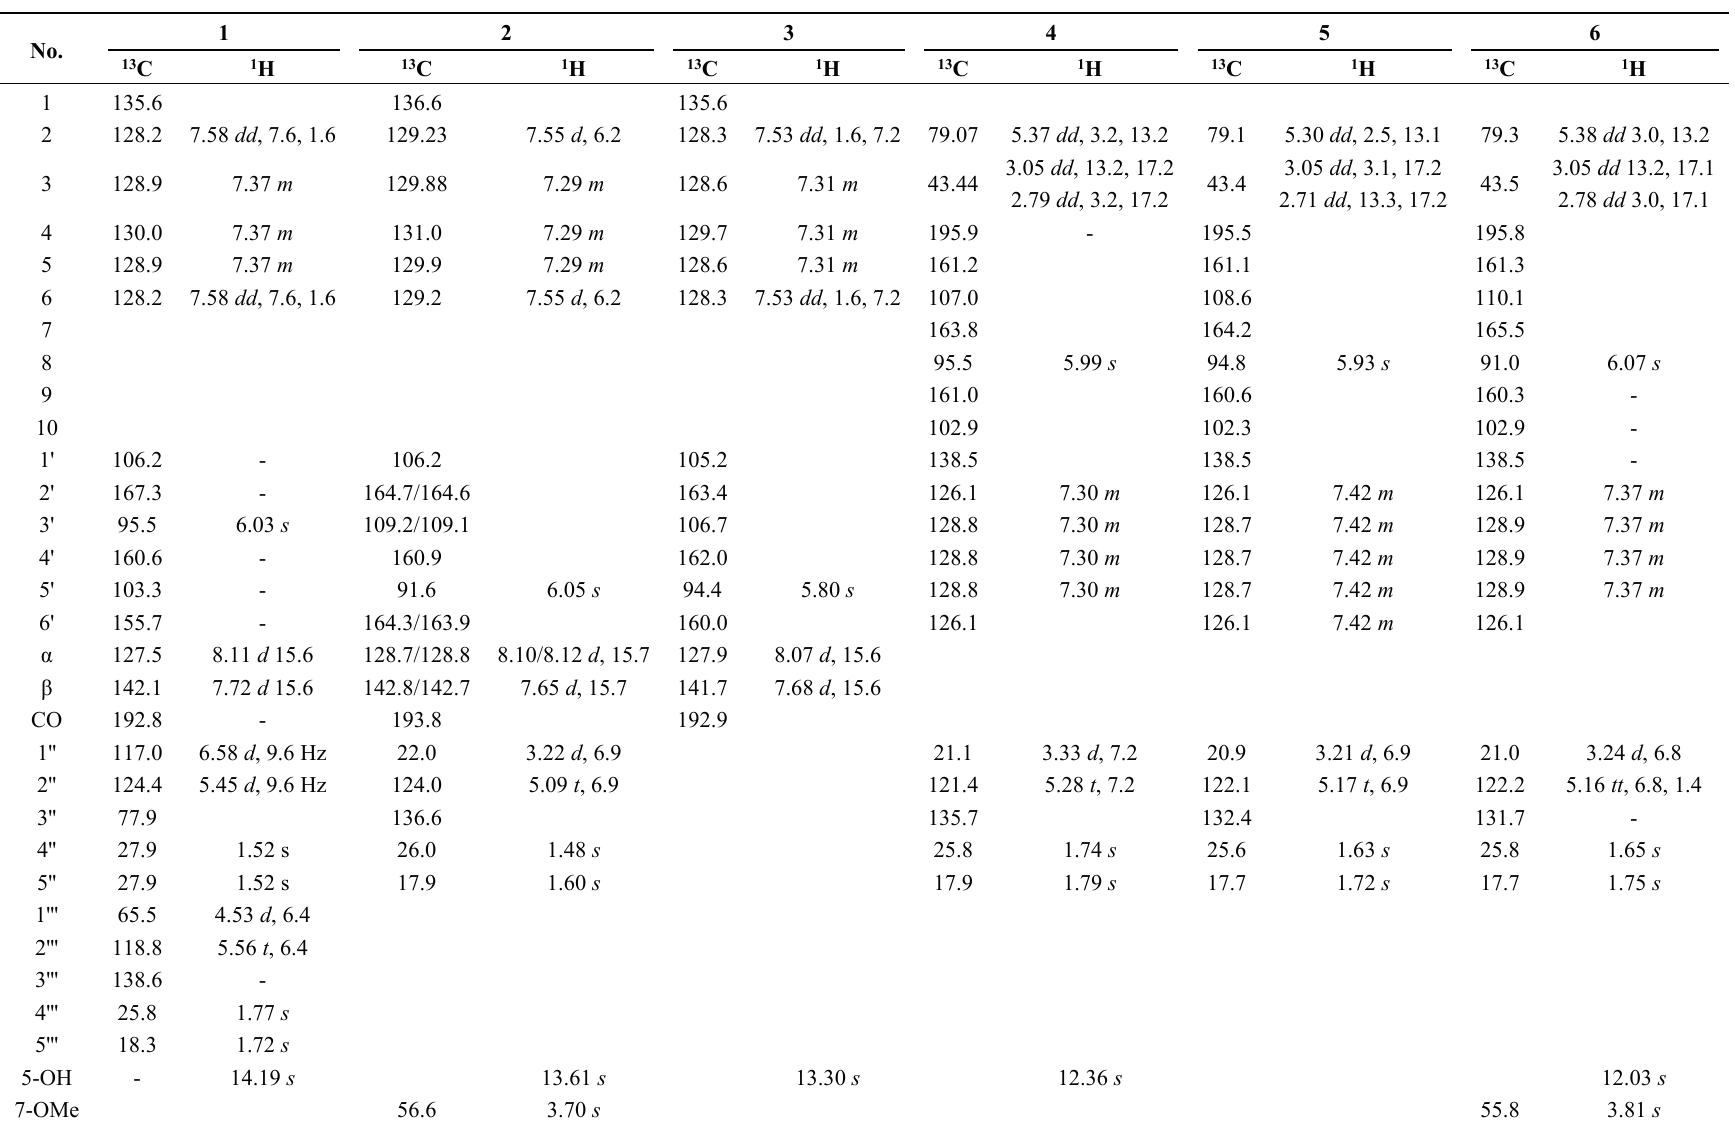
Table 1. 1 H- (400 MHz: m, J Hz) and 13 C- (100 MHz) NMR spectral data of isolated compounds 1 – 6 in CDCl 3